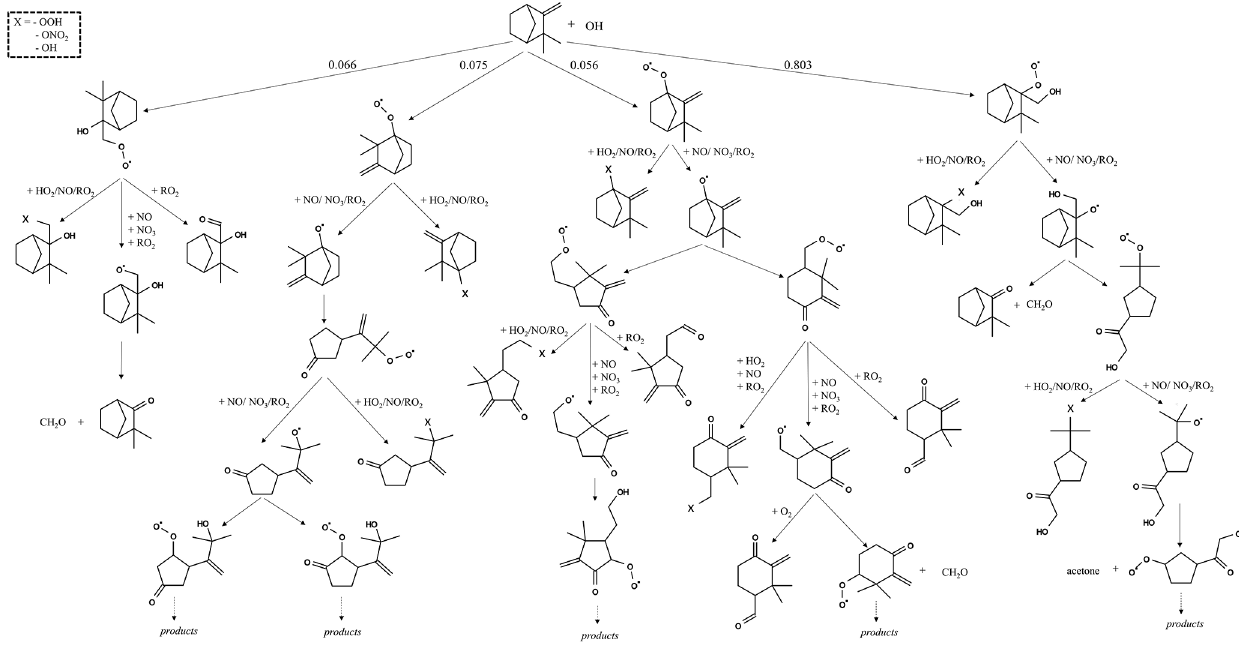
Figure 3. Initial oxidation pathways of camphene oxidation with OH as represented in GECKO-A (inorganic products are not shown). Table 1. Initial conditions for α -pinene and limonene chamber reactivity simulations. Abbreviation